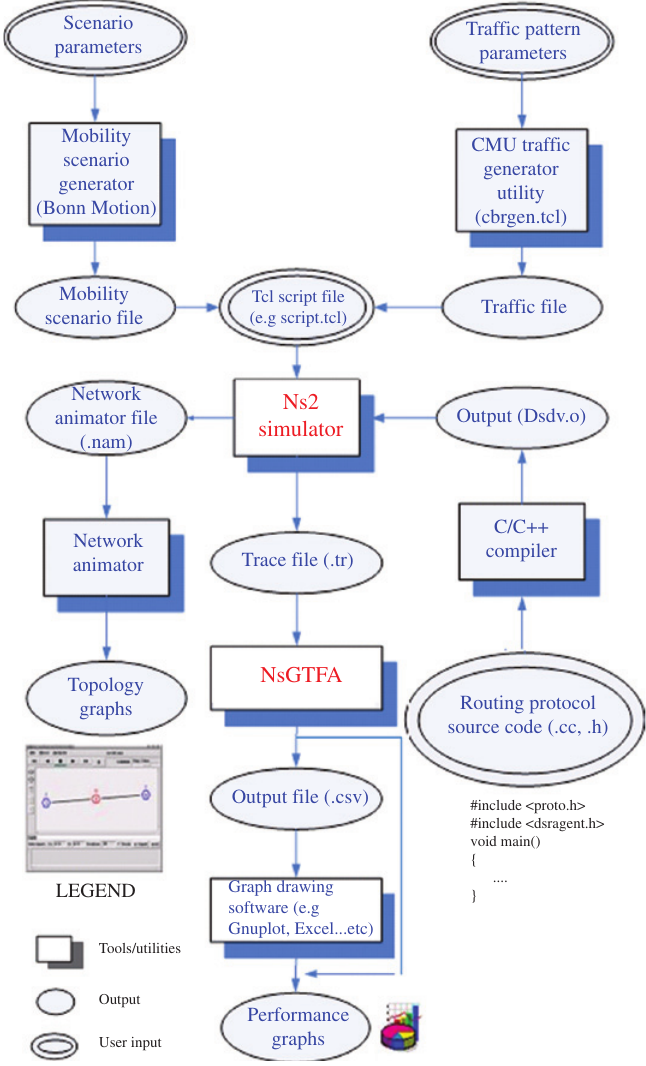
Figure 2. Trace File Flow Diagram in Ns2 and